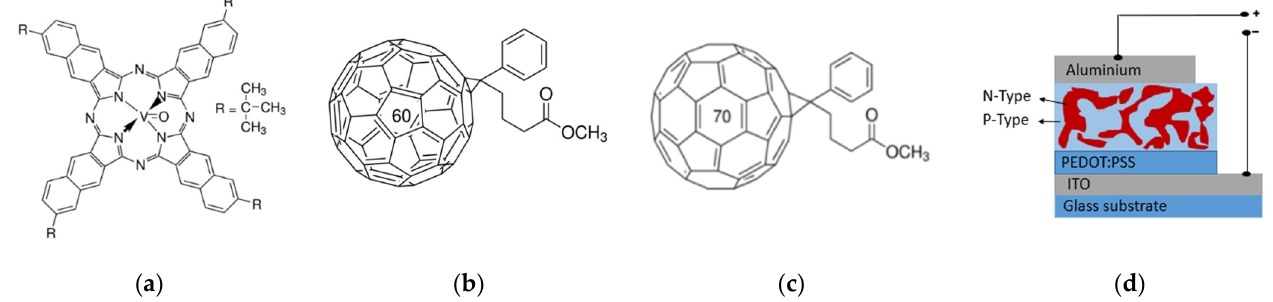
Figure 1. The molecular structure of ( a ) vanadyl 2,11,20,29-tetra tert-butyl 2,3 naphthalocyanine (VTTBNc), ( b ) [6, 6]phenyl-C61-butyric acid methyl ester (PC 61 BM), ( c ) [6, 6]phenyl-C71-butyric acid methyl ester (PC 71 BM) and ( d ) a schematic diagram of organic photodiode.